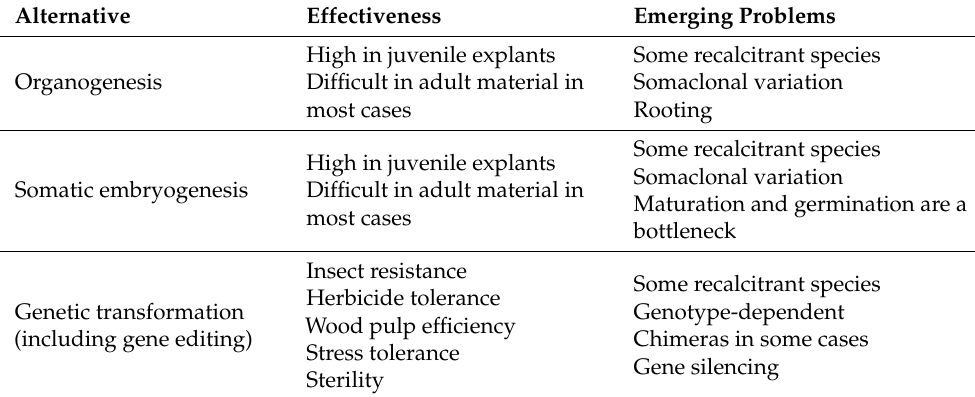
Table 3. Biotechnological alternatives to traditional breeding programs in